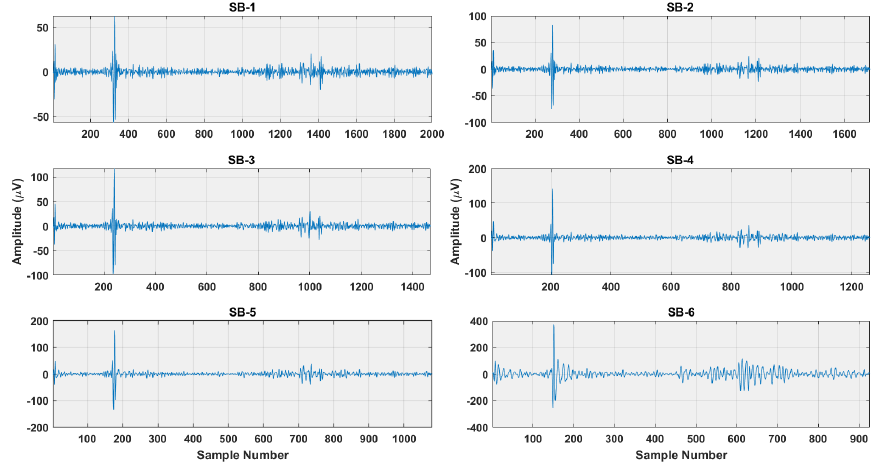
Figure 4. The subbands of RH brain activity obtained after r-TQWT